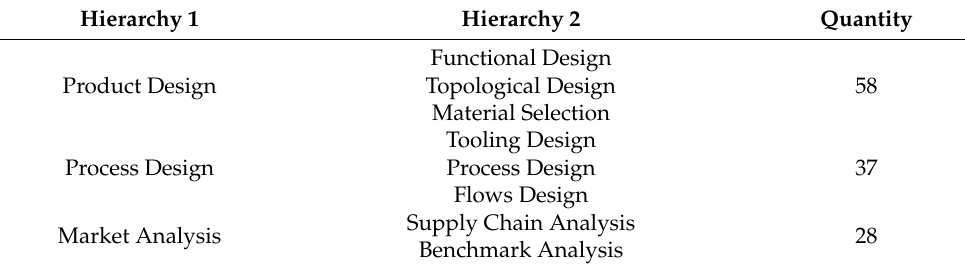
Table 11. Classification of current interaction matrix